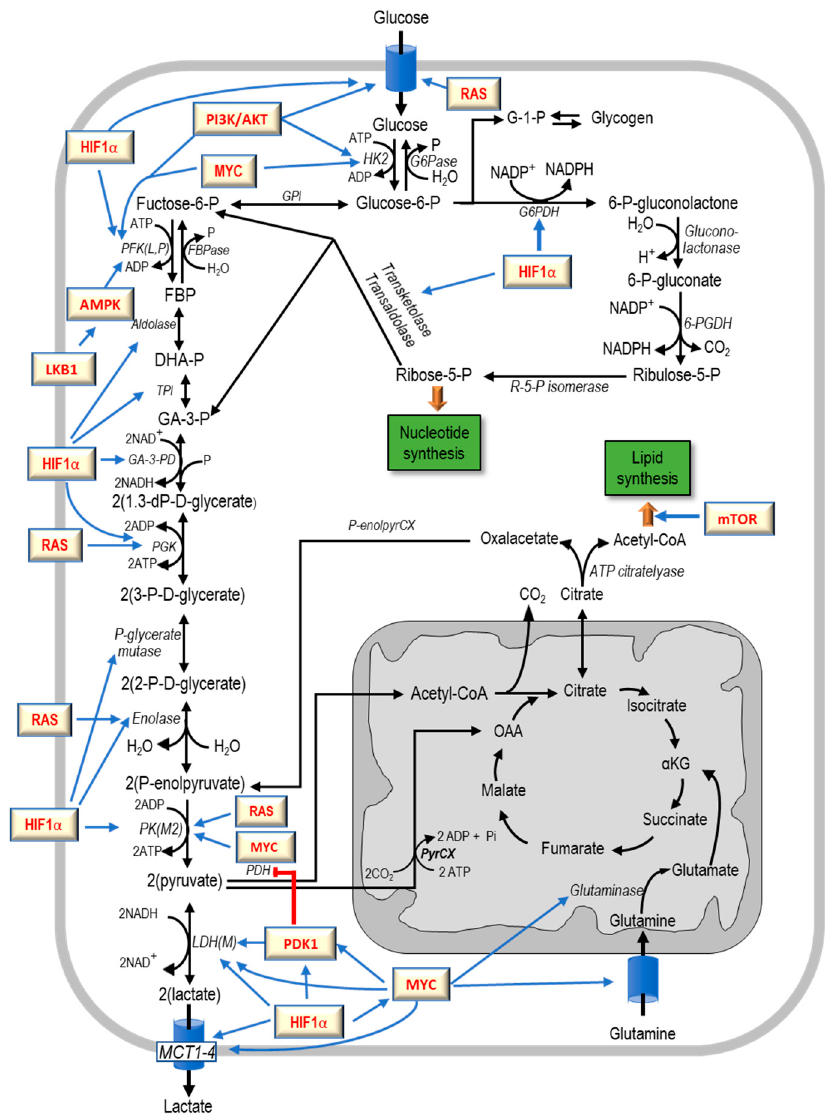
Figure 3. Glucosemetabolism. Substrates: DHA-P,dihydroxyacetonephosphate; F6P,fructose-6-phosphate; FBP, fructose-1,6-biphosphate; G-1-P, glucose-1-phosphate; 2dP-GLY, 2-diphosphoglycerate; OAA, oxaloacetate; α KG,alpha-ketoglutarate;2PG,2-phosphoglycerate;3PG,3-phosphoglycerate;P-enolpyruvate, phosphoenolpyruvate. Enzymes: FBPase, fructosebiphosphatase; GA-3 PD, glyceraldehyde-3-phosphate dehydrogenase; GPI, glucose-phosphate isomerase; LDH, lactate dehydrogenase; PDH, pyruvate dehydrogenase; PGK, phosphoglycerate kinase; PGM, phosphoglycerate mutase; PKM2, (pyuvate kinase M2; PYRCX, pyruvate carboxylase; TPI, triose-phosphate isomerase. Genes are shown in the yellow rectangles. Blue arrows: activation; red blunt arrow: inhibition.